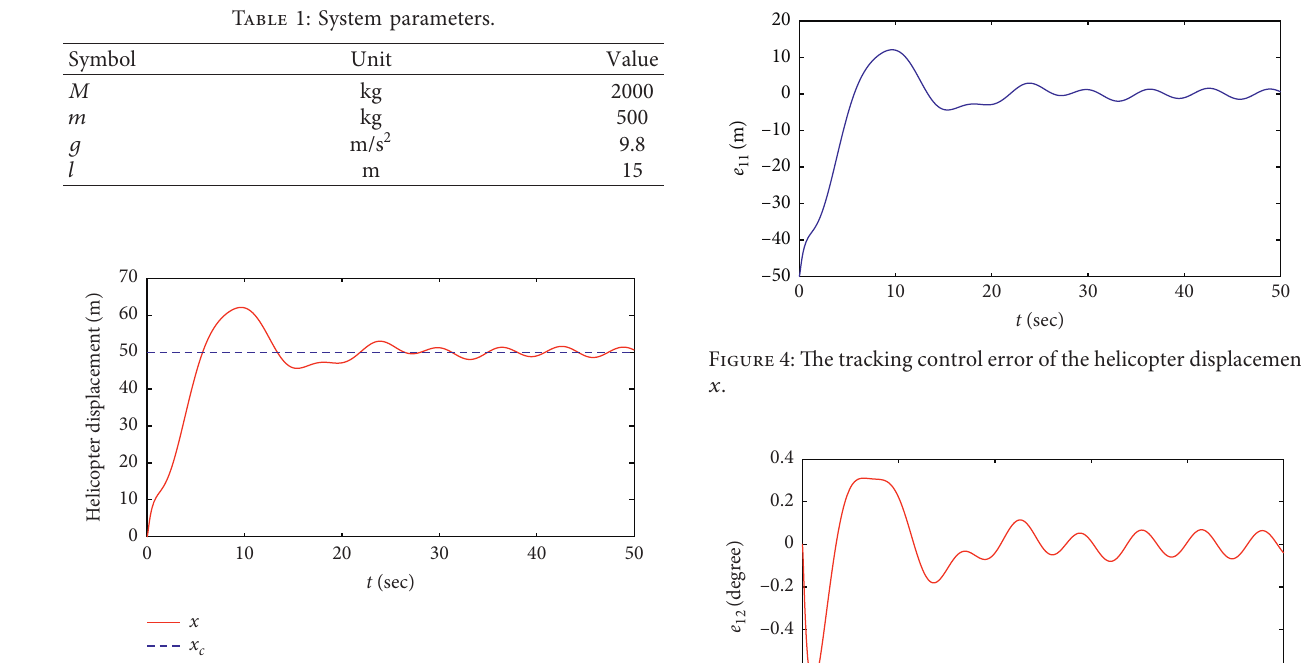
Figure 2: The tracking control result of the helicopter displacement x .